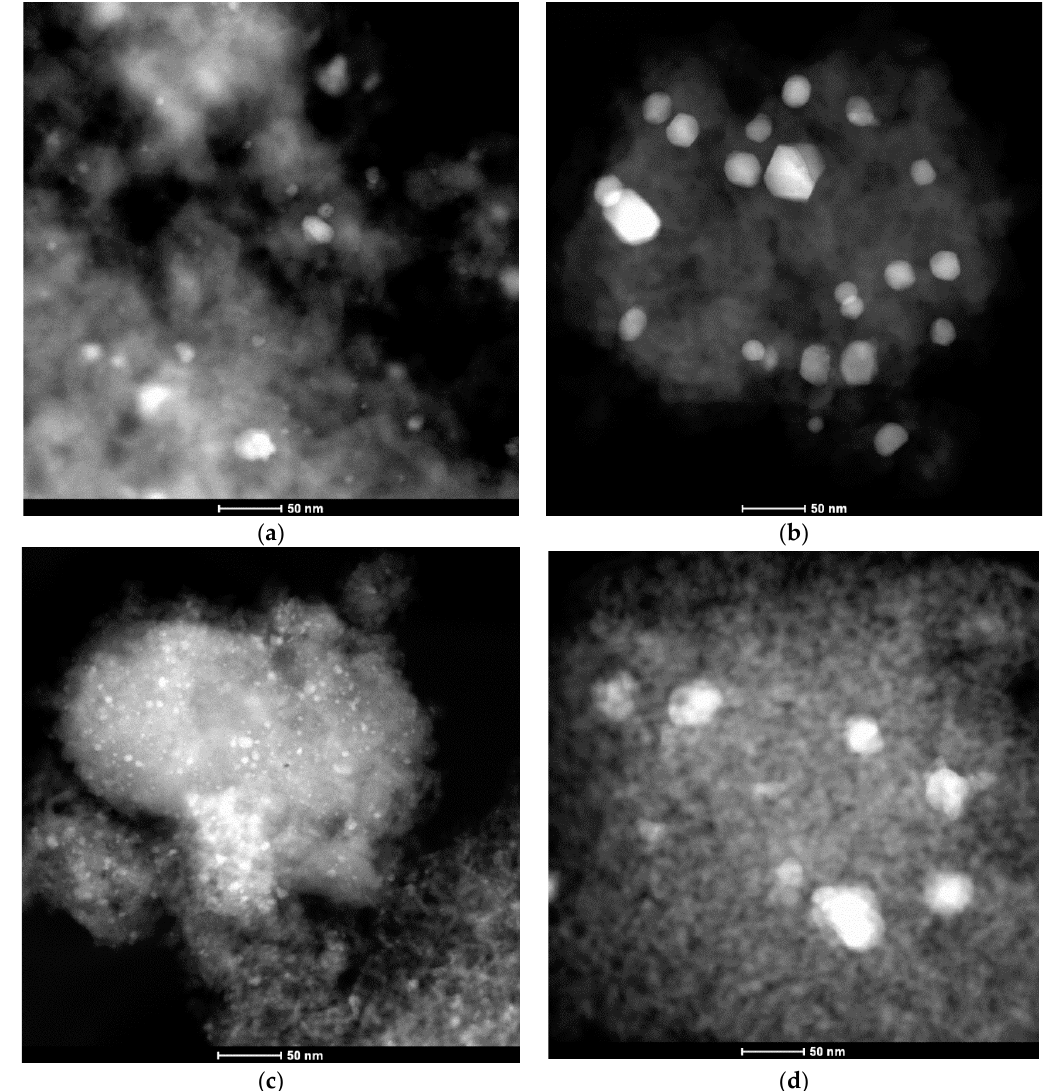
Figure 2. Scanning transmission electron microscopy (STEM) images of ( a ) degreened PdLTA, ( b ) 900 °C aged PdLTA, ( c ) degreened PdAl, and ( d ) 900 °C aged PdAl.